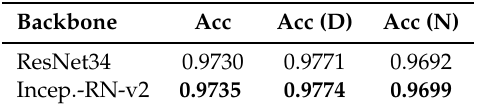
Table 2. Accuracy results of the binary segmentation experiment (measured with the Jaccard index): The experiment was carried out on all test images and separately on the daylight (D) and night vision (N) images only. Best results in